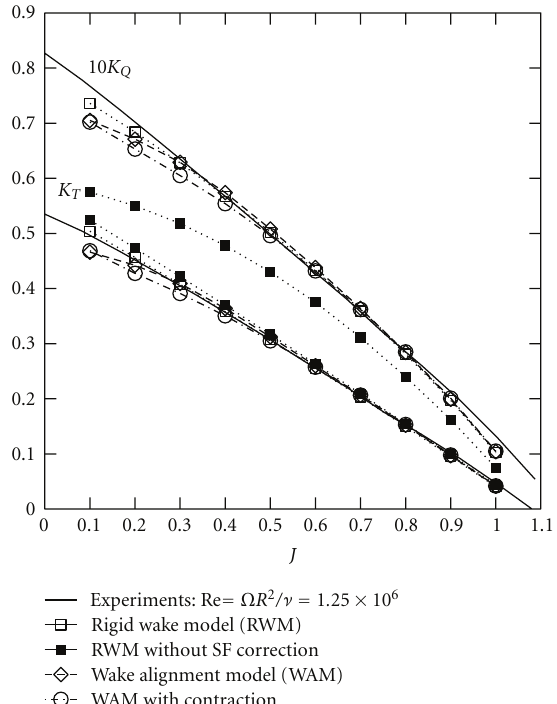
Figure 5: Thrust and torque coe ffi cients for propeller Ka4-70 showing the influence of the wake alignment model and the leading edge suction force (SF) correction.